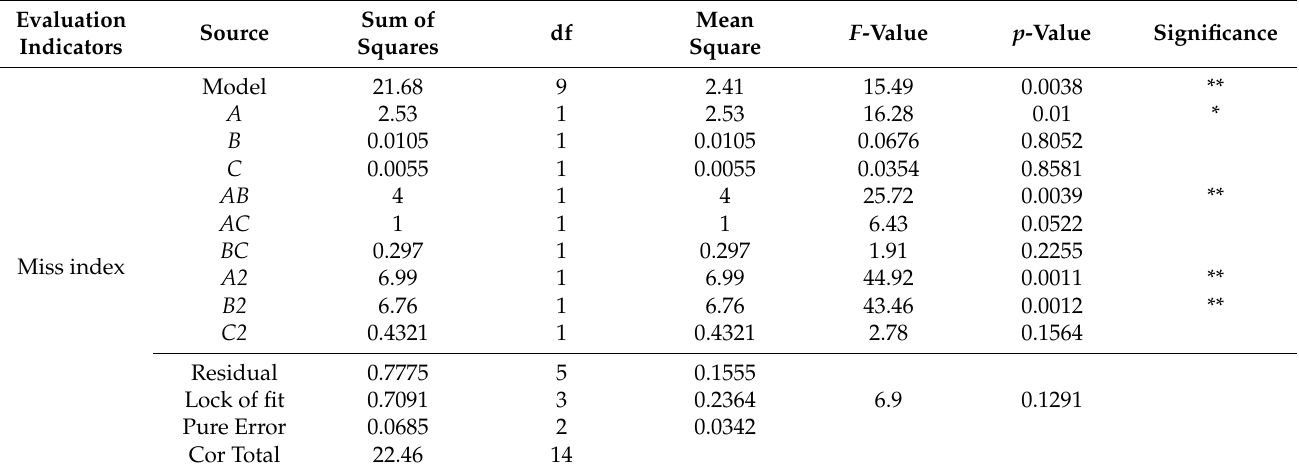
Table 6. Analysis of variance for the miss